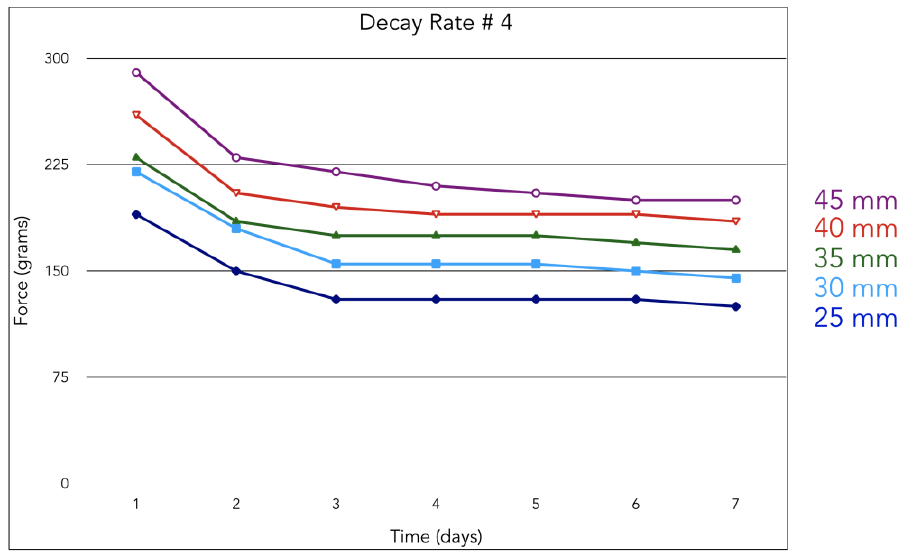
Figure 10. Force delivered by an elastic #4 during a week.